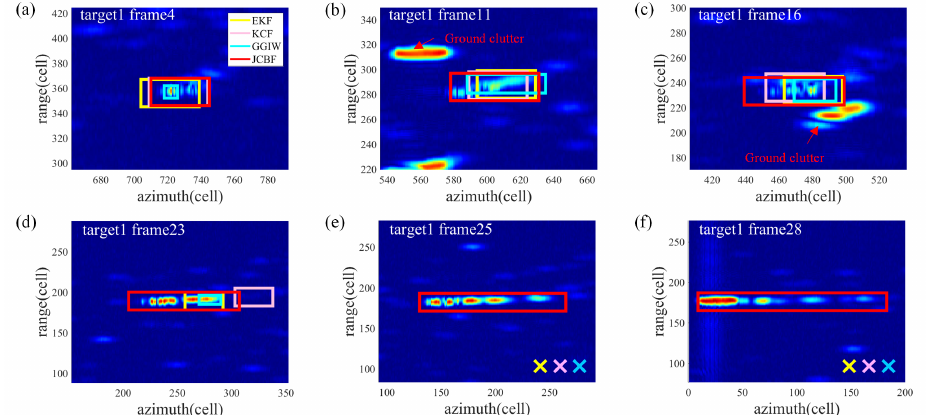
Figure 7. Tracking results of target 1 at some key frames. ( a – f ): Tracking results for each filter when the shape of target 1 changes .